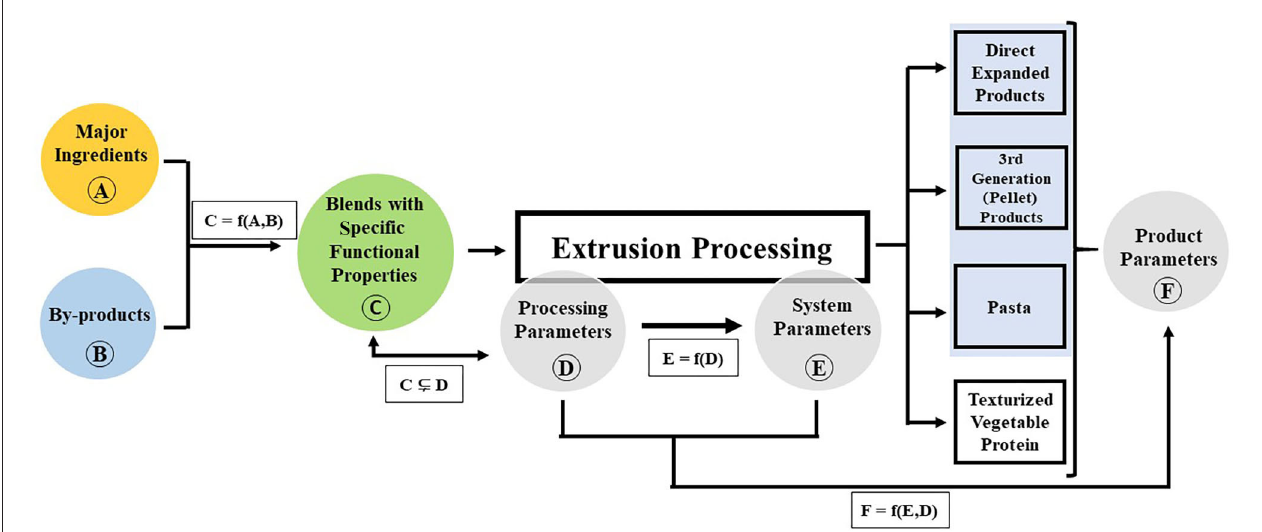
FIGURE 1 | Dependences of factors during extrusion processing. C = f(A,B): C is a function of A and B; C ( D: C is a subset of D; E = f(D): E is a function of D; F = f(E,D): F is a function of E and D. The paper reviews the effect of by-products on direct expanded products, 3rd generation products, and pasta products; texturized vegetable protein products are not covered but may offer a great opportunity to do so in the